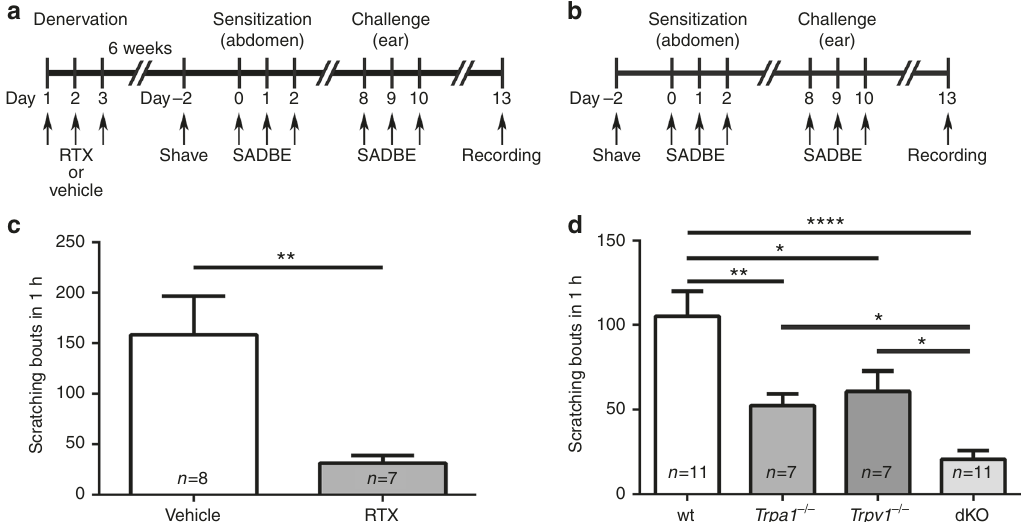
Fig. 2 Both TRPA1 and TRPV1 channels are involved in SADBE-induced persistent itch. a Schematic protocol of nociceptor ablation and induction of SADBE- induced ACD model; ( b ) Schematic protocol of SADBE-induced ACD model; ( c ) SADBE-induced spontaneous scratching in wt mice pre-treated with vehicle or RTX. Data are presented as mean ± SEM. Asterisks indicate statistical signi fi cance. ** p < 0.01, Student ’ s t -test; ( d ) SADBE-induced spontaneous scratching in wt, Trpa1 − / − , Trpv1 − / − , and Trpa1 − / − / Trpv1 − / − dKO mice. Data are presented as mean ± SEM. Asterisks indicate statistical signi fi cance. * p < 0.05; ** p < 0.01; **** p < 0.0001,